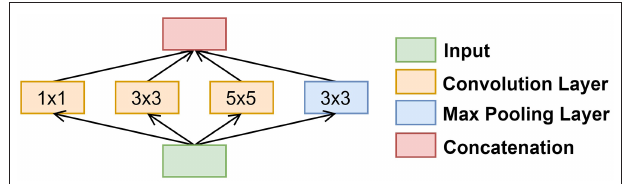
FIGURE 3 | Block diagram of the naïve inception